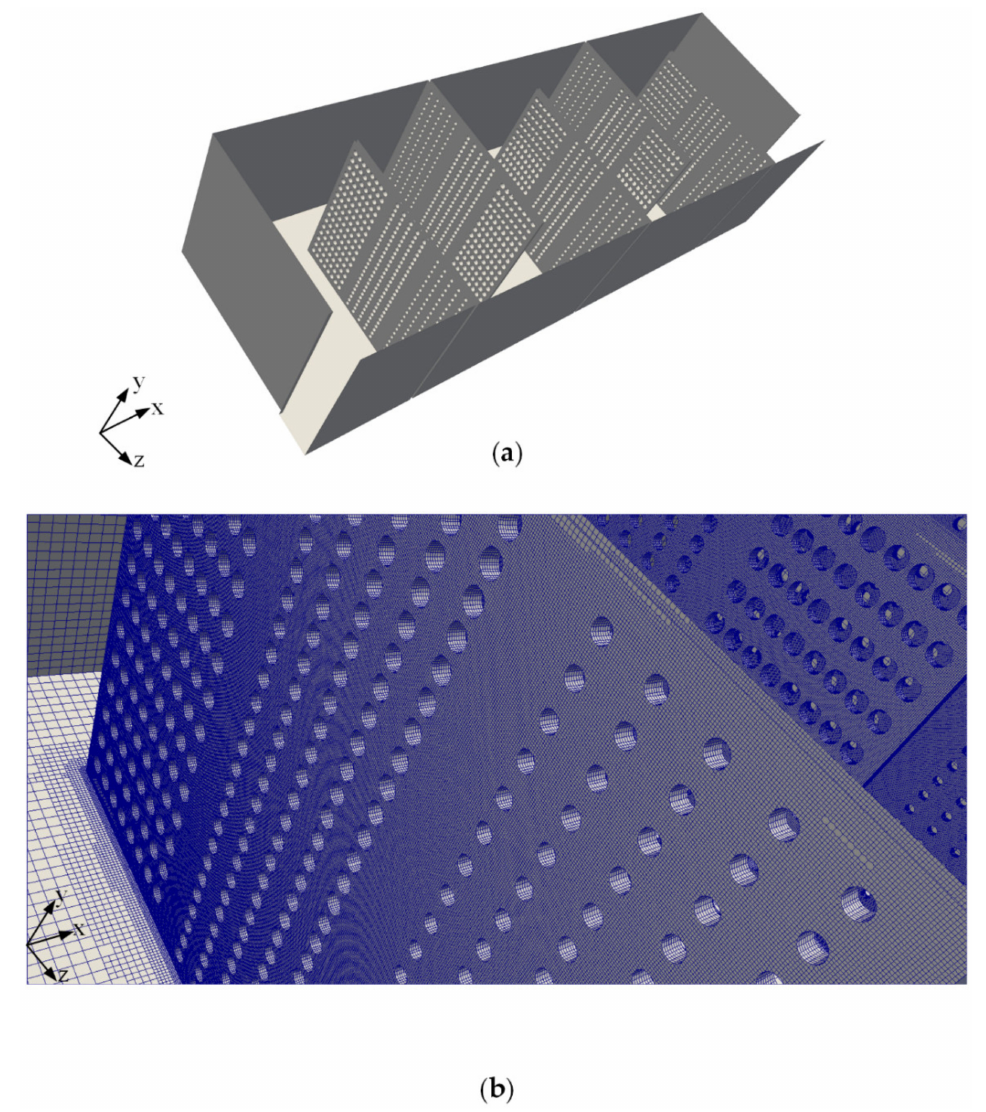
Figure 2. Computational mesh generated using blockMesh and snappyHexMesh: ( a ) wall boundaries of the contact system; ( b ) zoomed view of the hexahedra mesh over the perforated ba ffl